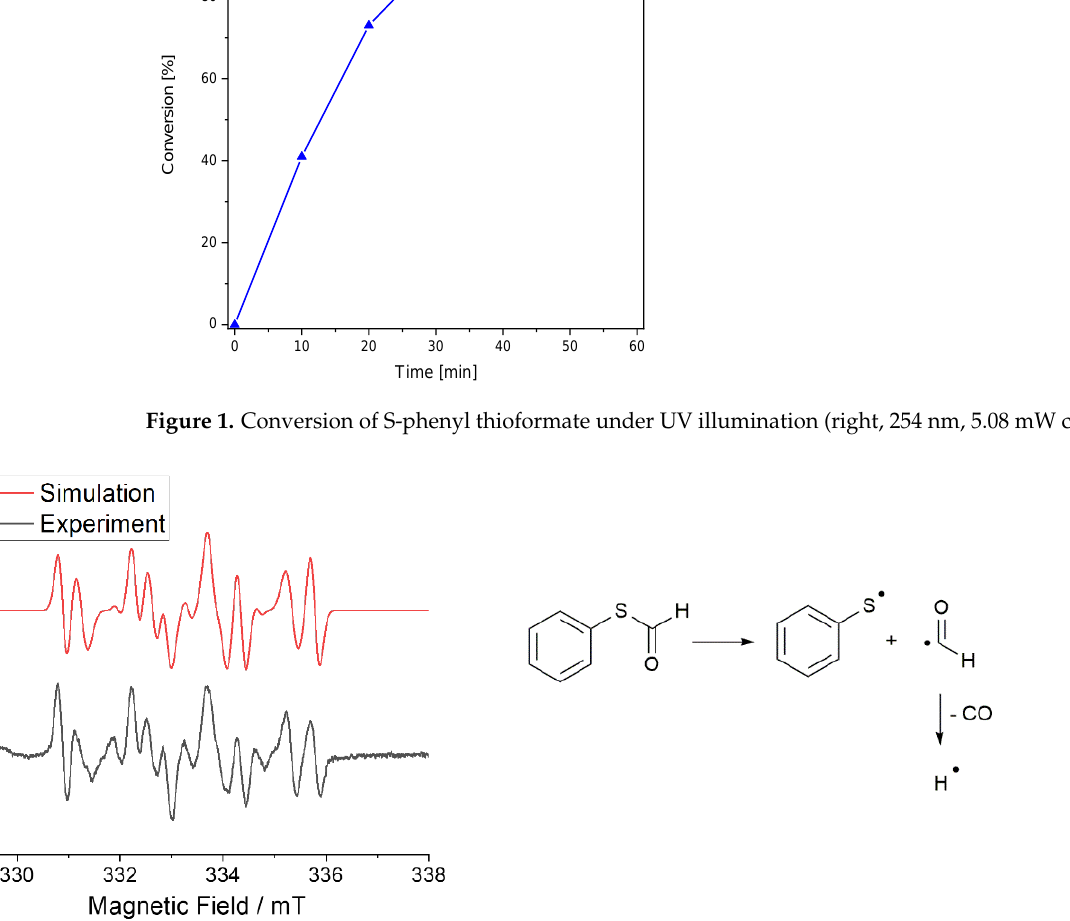
Figure 2. ( Left ): experimental (grey) and simulated(red) EPR spectrum of S-phenyl thioformate pho-